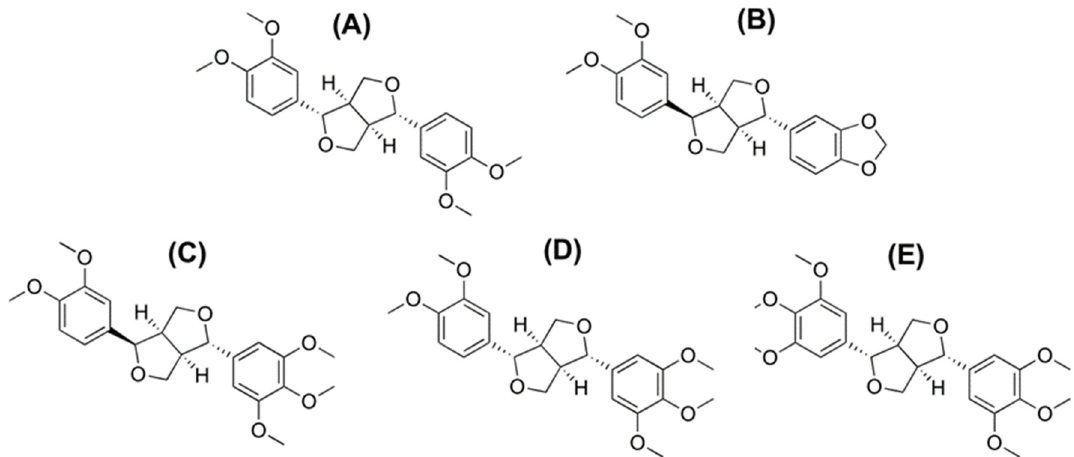
Figure 1. Chemical structures of ( A ) eudesmin, ( B ) fargesin, ( C ) epimagnolin A, ( D ) magnolin, and ( E ) yangambin.